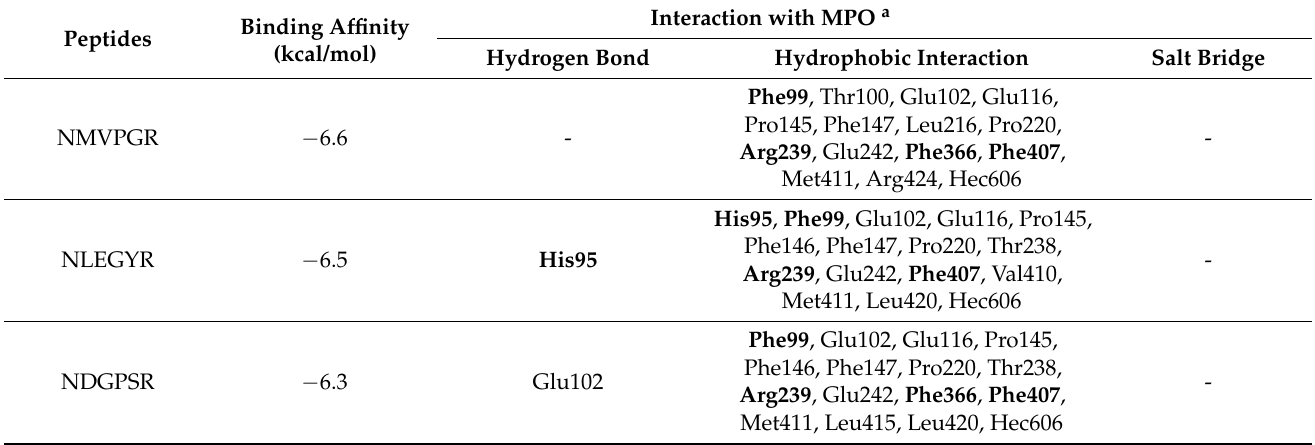
Table 7. Binding affinities and types of interactions between myeloperoxidase (MPO) and five corn silk peptides predicted as non-toxic, non-allergenic and cell-penetrating peptides, in comparison with two reference peptides.